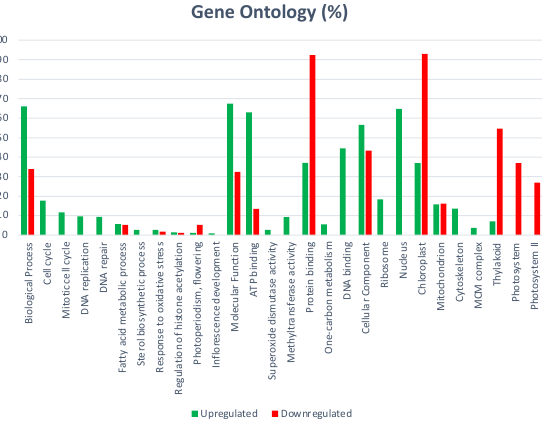
Figure 2. Cellular components regulated during MTs development of potato induced in the dark.